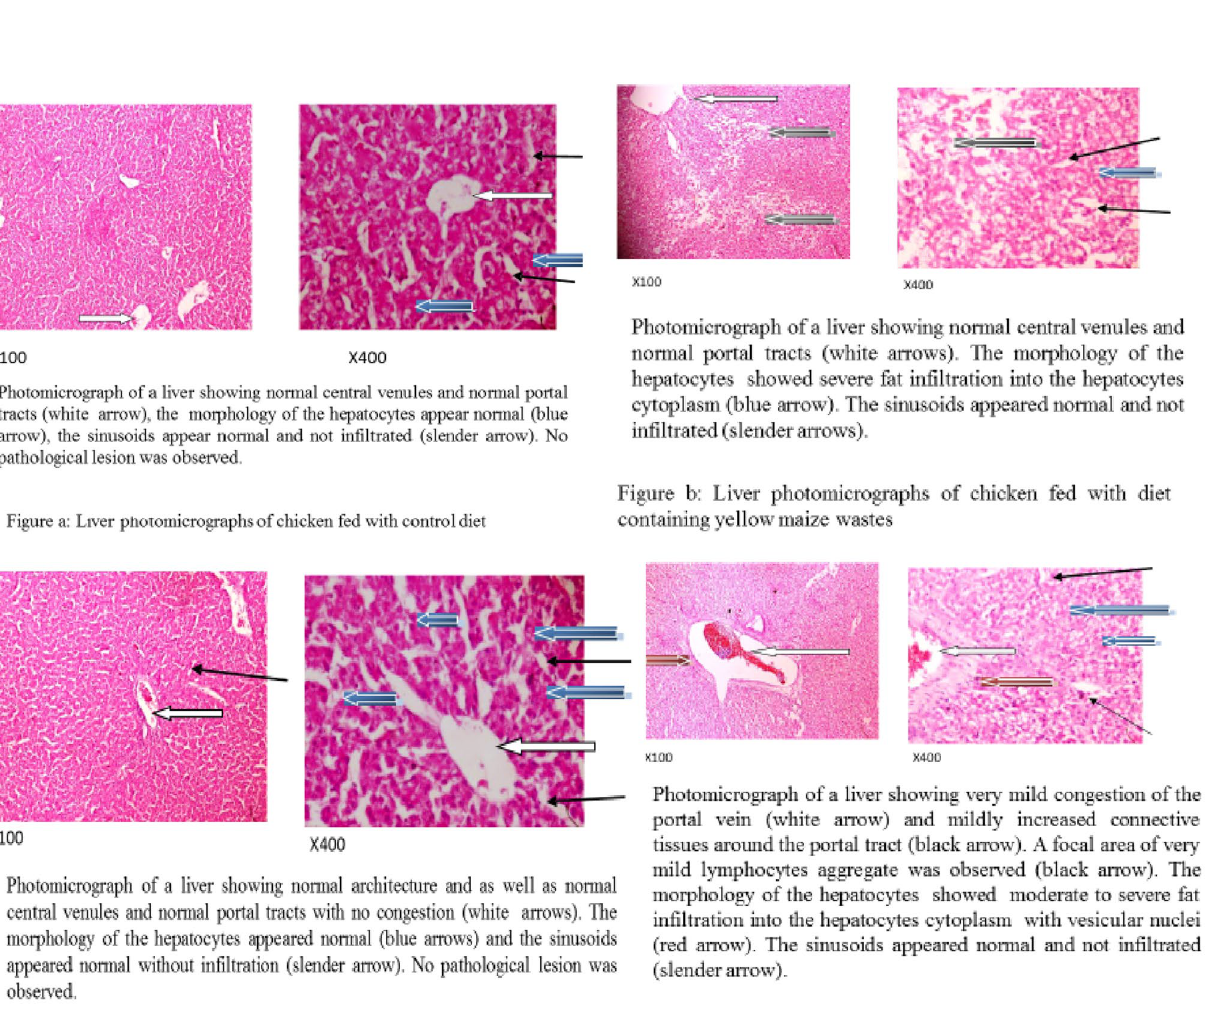
sajor-caju . d Liver photomicrographs of chicken fed with diet con- taining mycomeat from yellow maize wastes using mutant strain of P.